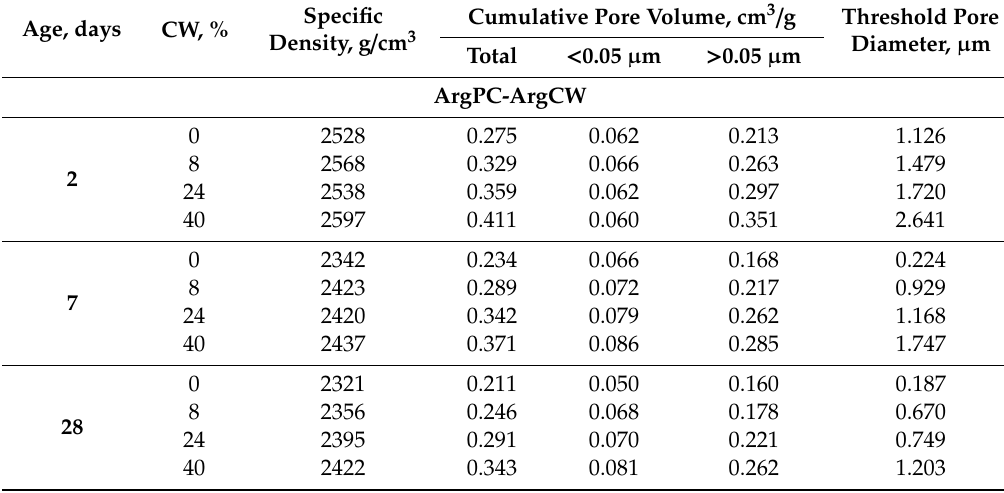
Table 4. Specific density and porosity parameters assessed by